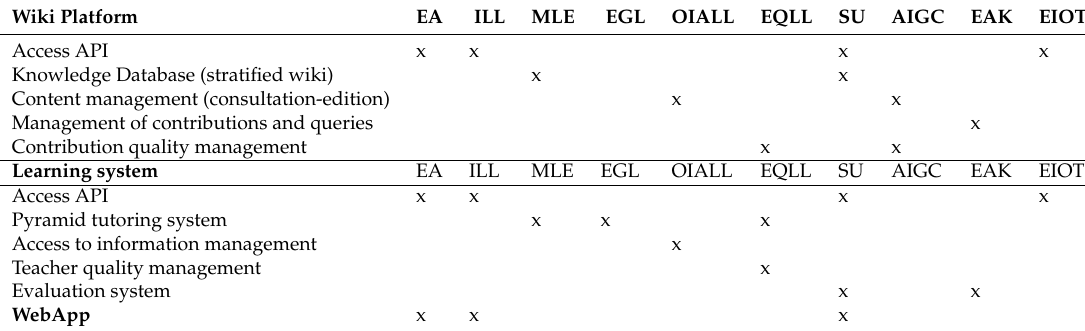
Table 2. Grouped